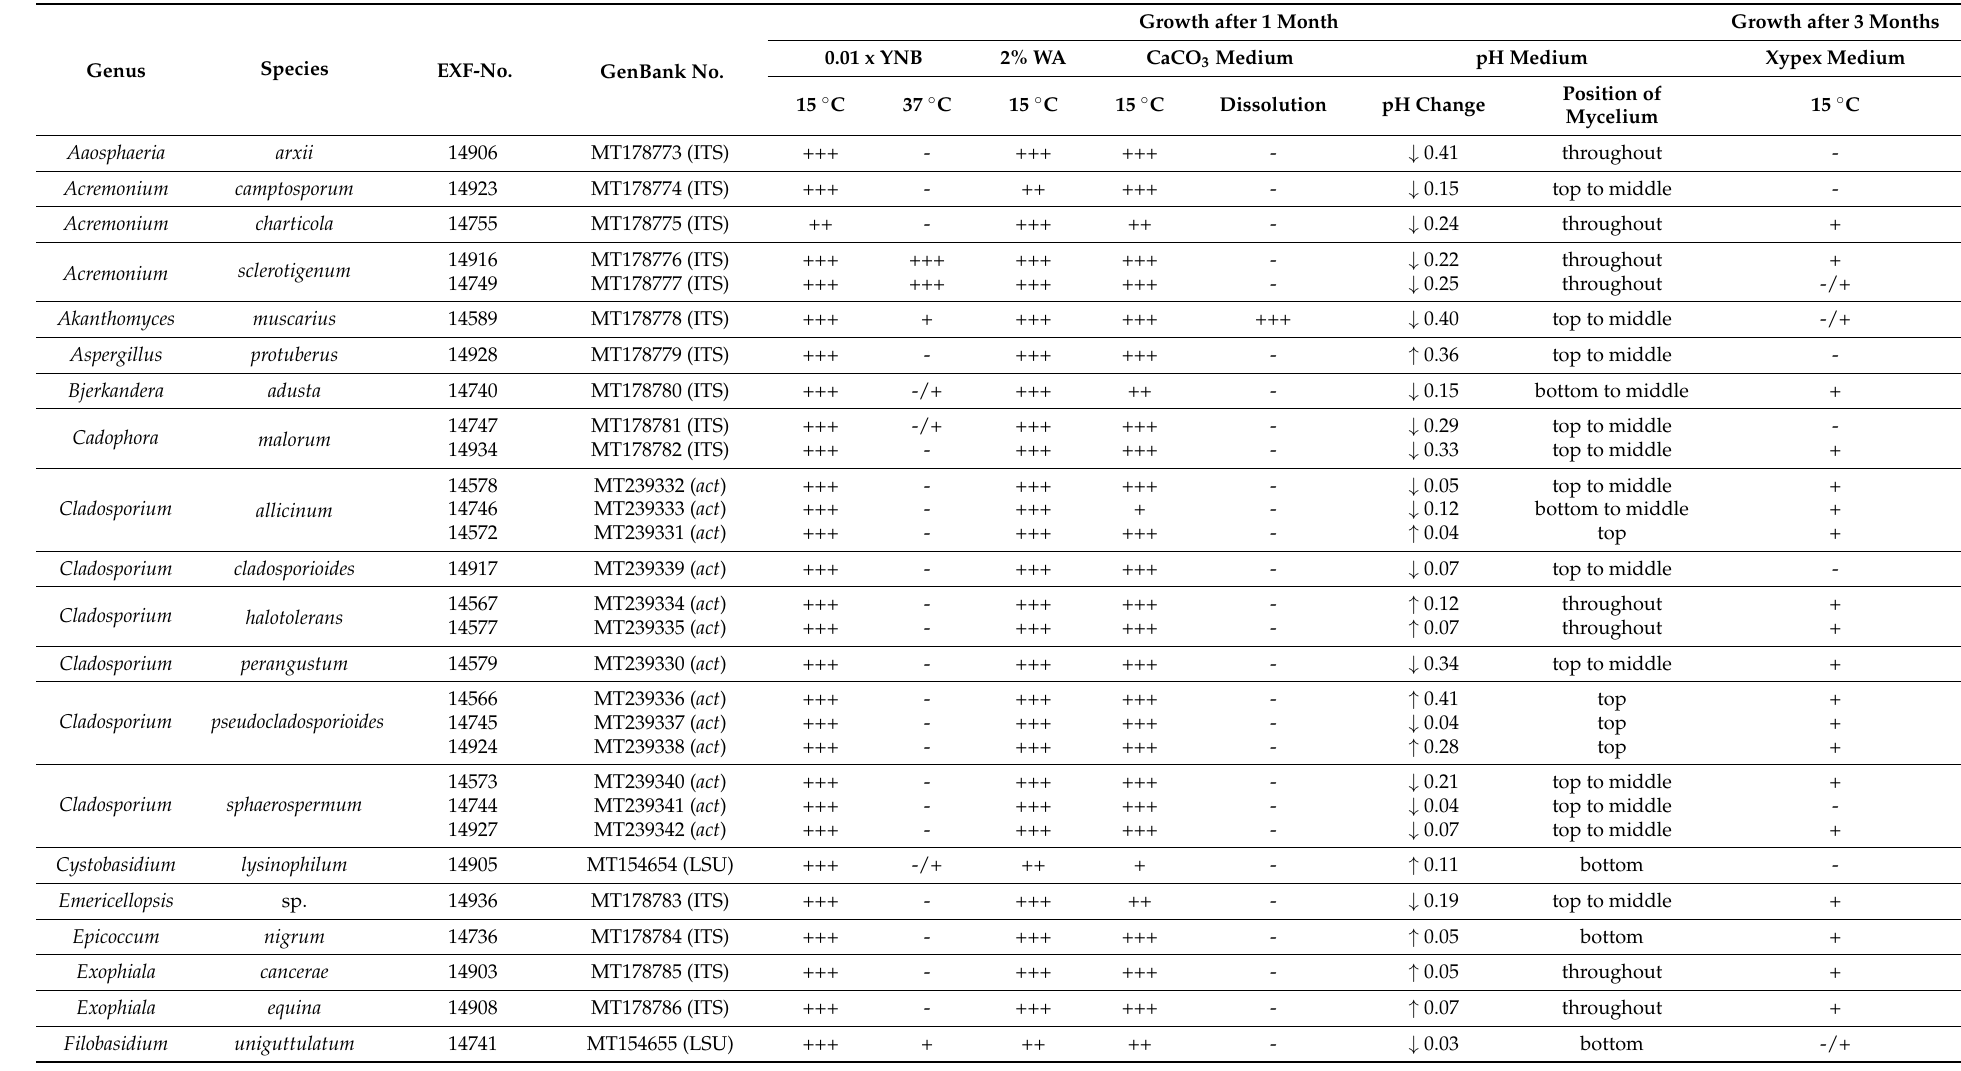
Table 2. Representative fungal strains isolated from water storage tanks and drinking water, used to test the growth in